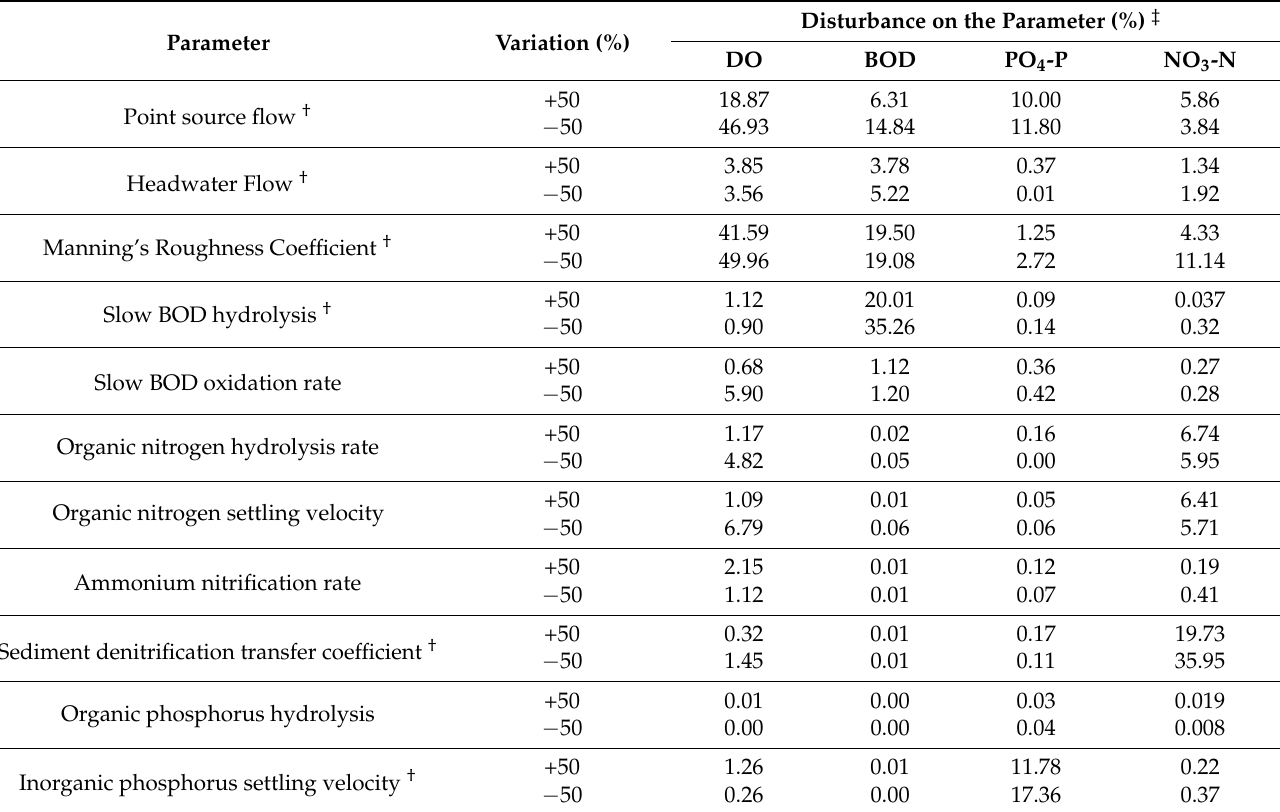
Table 4. Sensitivity analysis results for selected parameters in